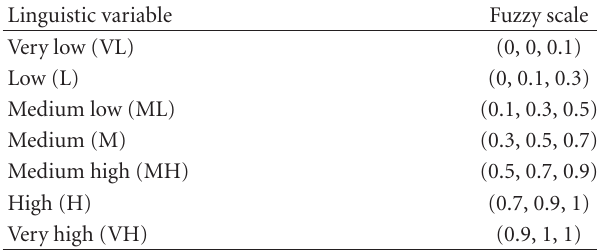
Table 4: Chen’s fuzzy scale.